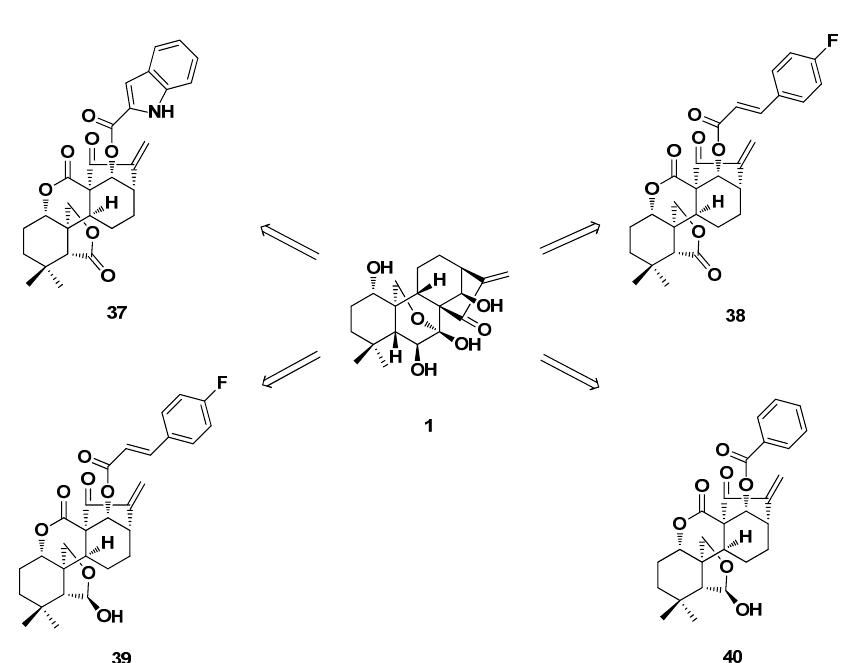
Int. J. Mol. Sci. 2016 , 17 , 1395 12 of 18